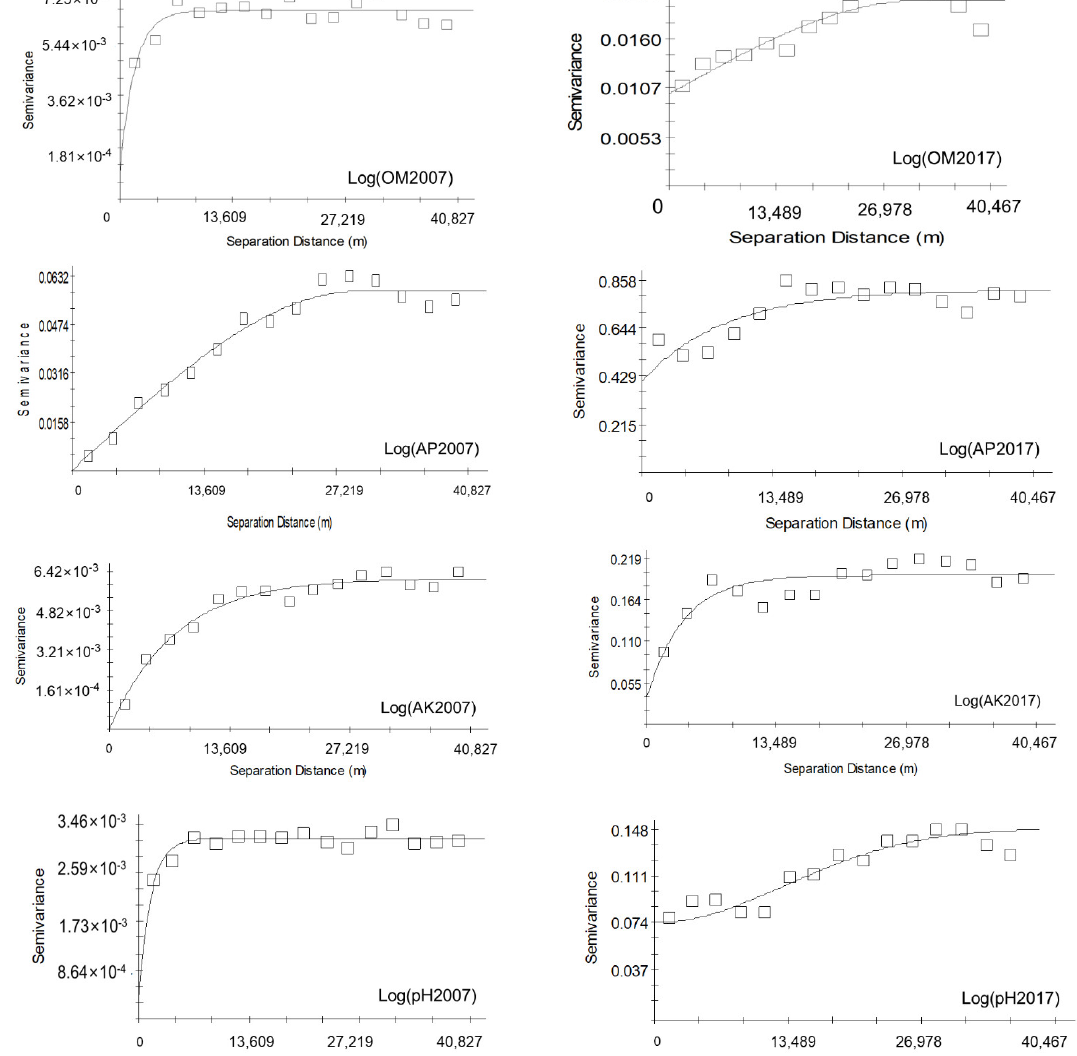
Figure 4. Experimental semivariograms for log (OM), log (AP), log (AK), and log (pH) in 2007 and 2017, Hefeng. Table 7. Difference significance tests of soil properties between two crop years (2007 and 2017) and eight cropping systems.